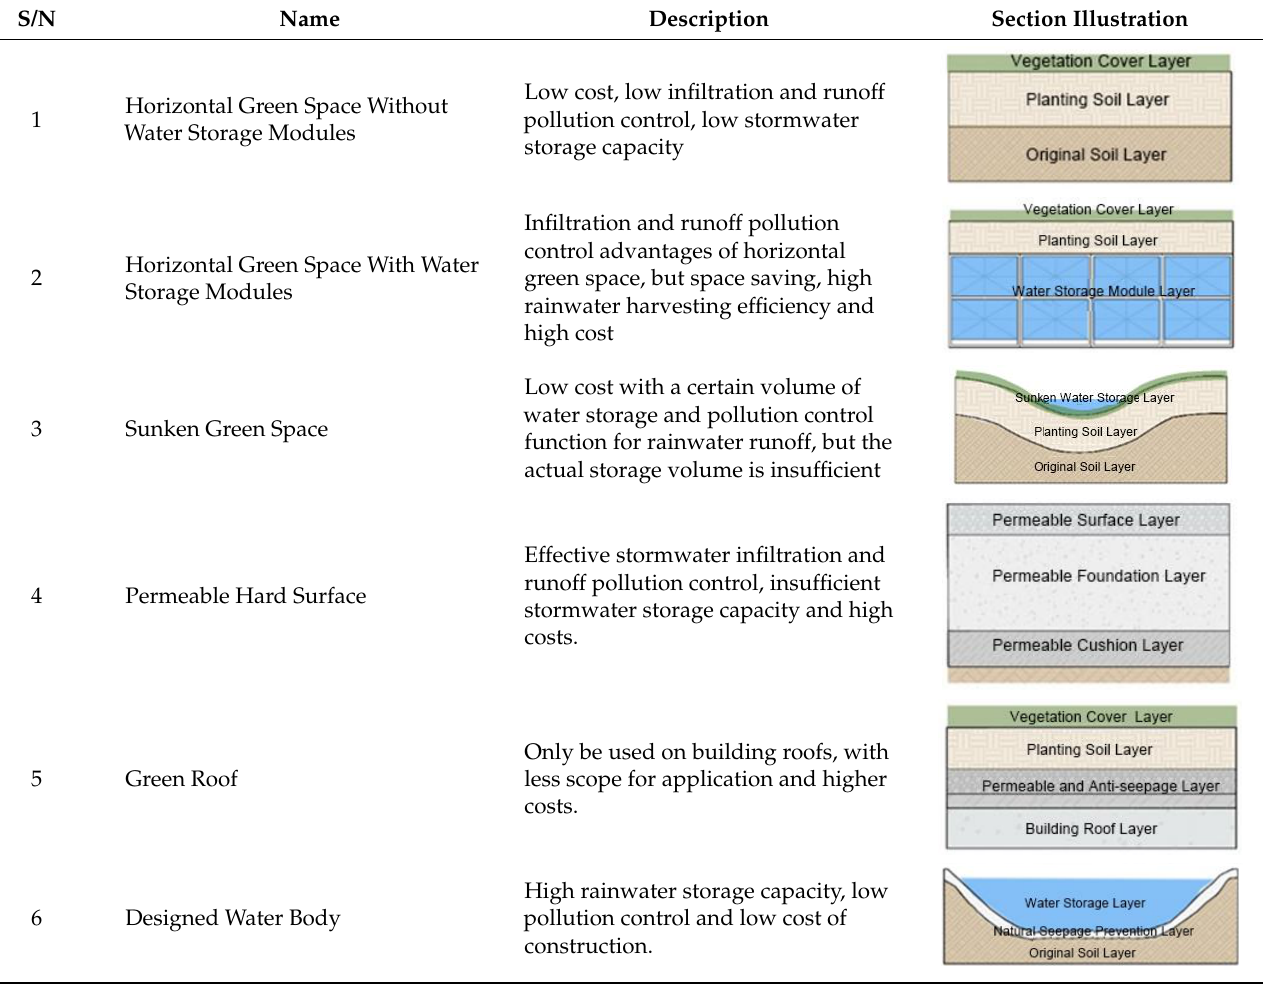
Table 2. Description of the characteristics of 6 types of typical sponge facilities.